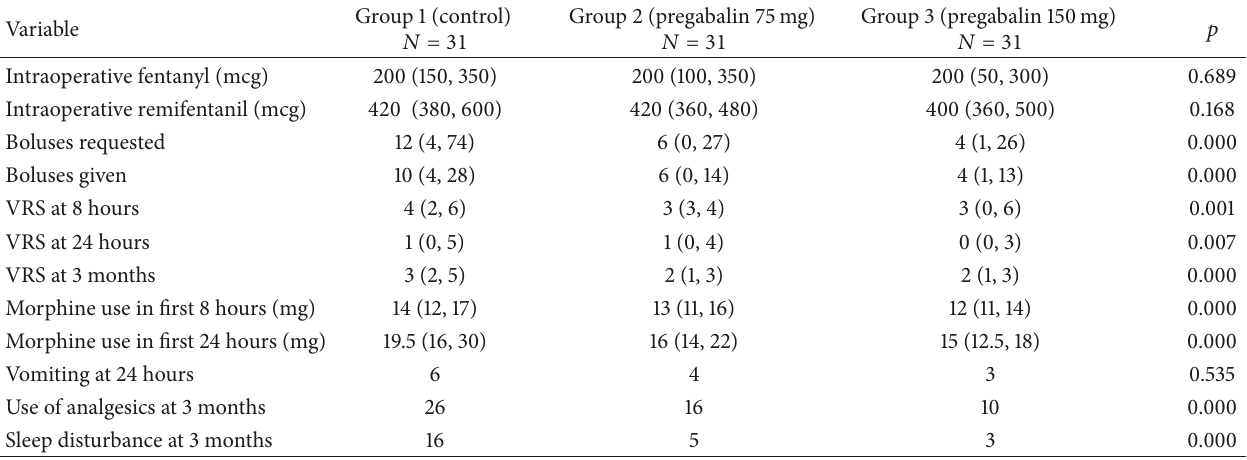
Table 2: Postoperative analgesic use and pain intensity. Data reported as median (minimum, maximum). 𝑝 values for comparisons between study groups were calculated using the Kruskal-Wallis or Chi-square tests as appropriate. 𝑝 values for significance were adjusted to 0.05/12 = 0.0042 using Bonferroni correction for multiple comparisons.